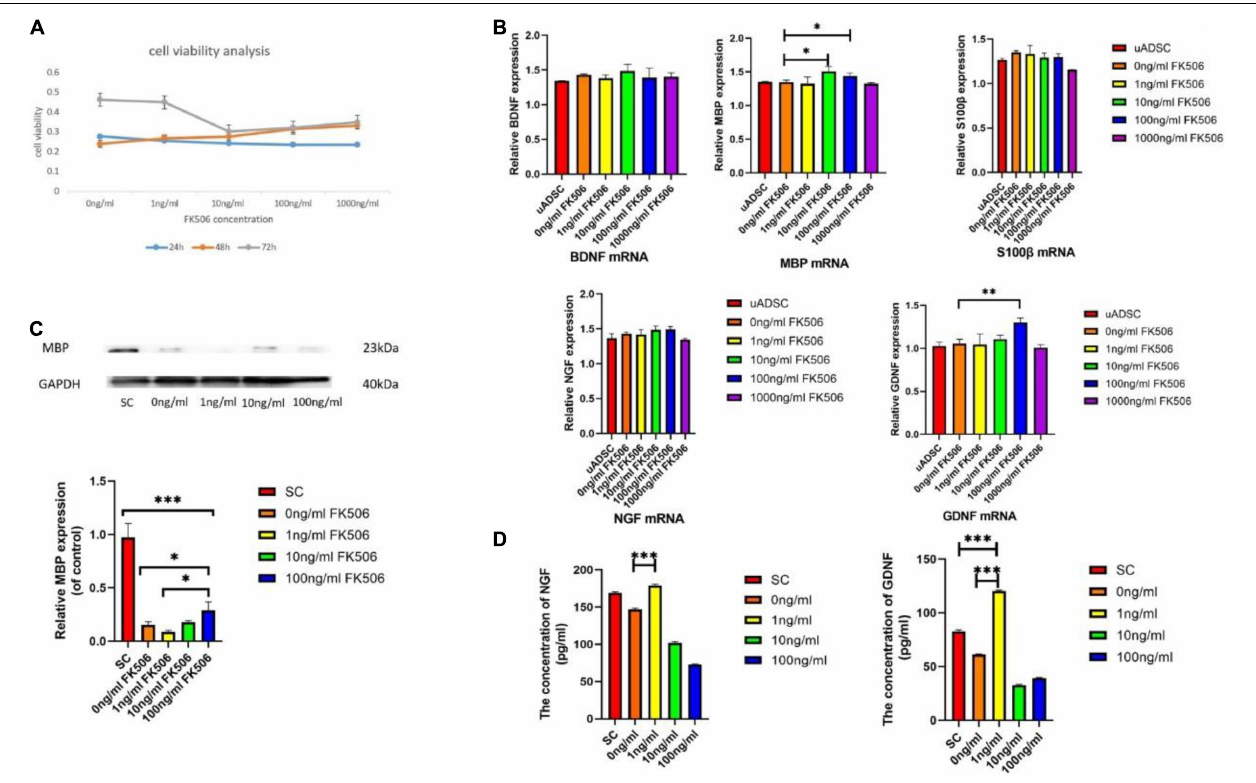
FIGURE 3 | (A) Effects of different doses of FK506 on ADSC viability. Data are presented as the mean value ± SD from triplicate experiments. (B) Effects of FK506 on the mRNA expression of S100 β and neurotrophic factors in differentiated ADSCs. Undifferentiated ADSCs were set up as negative control. The genes expression was assessed by quantitative real-time PCR after treatment of FK506 for 3 days. Data are presented as the mean value ± SD from triplicate experiments. (C) Western blot results for MBP expression. SC lysates were set up as the positive control group. Three independent replicates were included for each group. GAPDH was used as a loading control. The relative MBP expression of control was analyzed; ∗ p < 0.05, ∗∗ p < 0.01, ∗∗∗ p < 0.001, compared to the 100 ng/mL FK506 treatment group; (D) The levels of NGF and GDNF secreted by ADSCs. SC supernatants were set up as the positive control group. ∗∗∗ P < 0.001, compared to the 0 ng/mL FK506 treatment